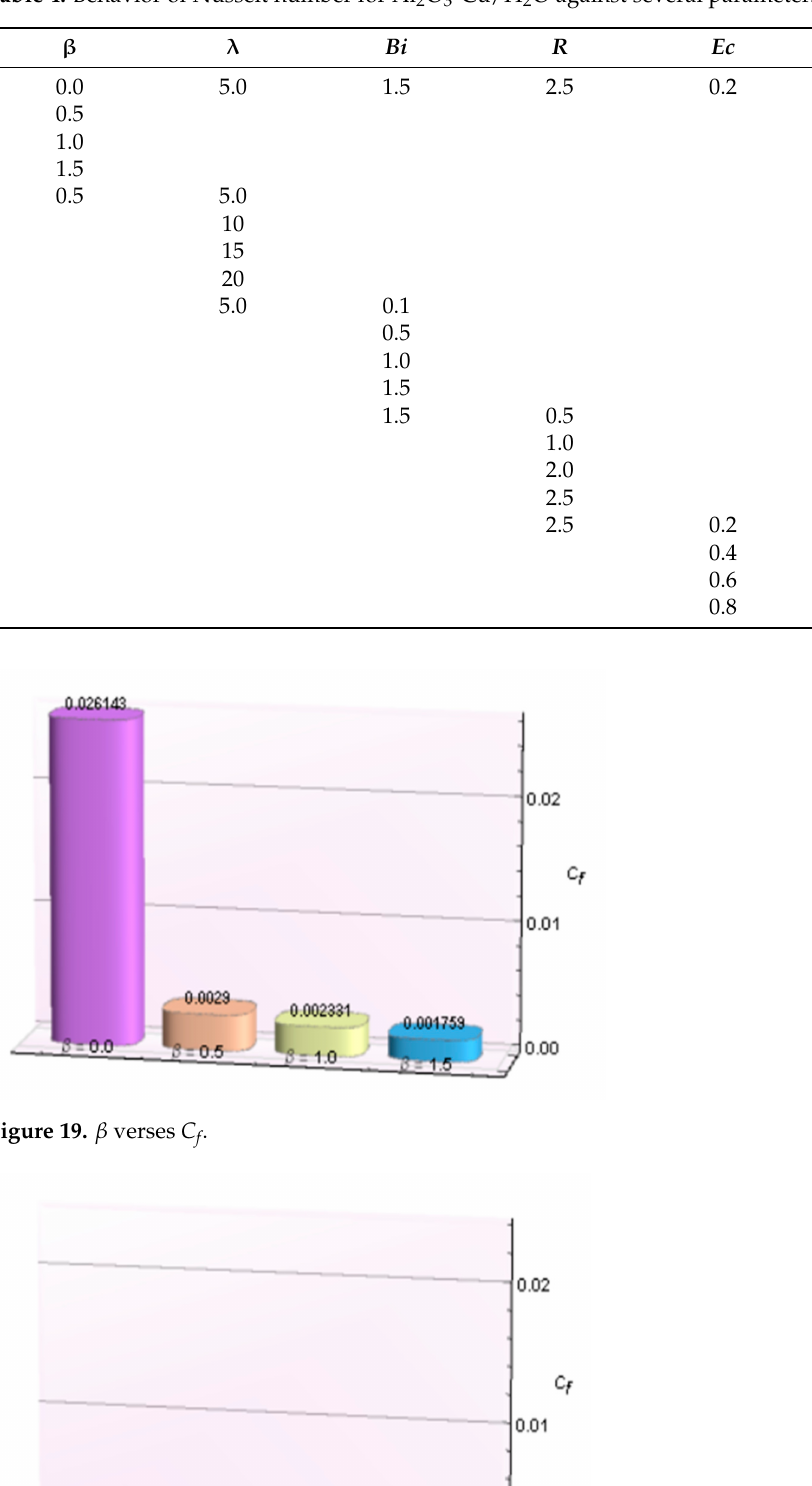
Table 4. Behavior of Nusselt number for Al 2 O 3 -Cu/H 2 O against several parameters.